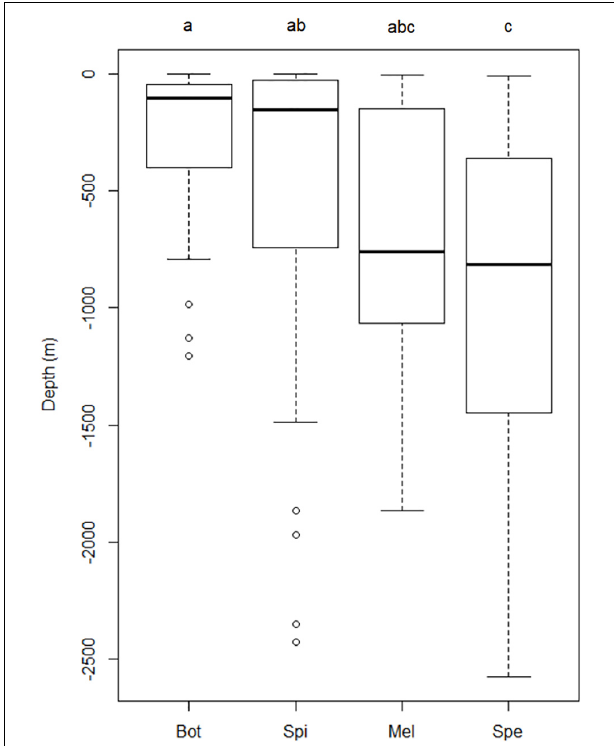
FIGURE 5 | Boxplots of sightings of four most abundant cetacean species associated with depth in Wakatobi: Bot, Bottlenose dolphin ( n = 27); Spi, Spinner dolphin ( n = 63); Mel, Melon-headed whale ( n = 13); Spe, Sperm whale ( n = 20). Significant differences of depth among species were checked using Kruskal–Wallis. Wilcoxon post hoc test was applied for multiple comparisons after Kruskal–Wallis testing indicated a significant difference. The same letters indicate the boxplots do not differ